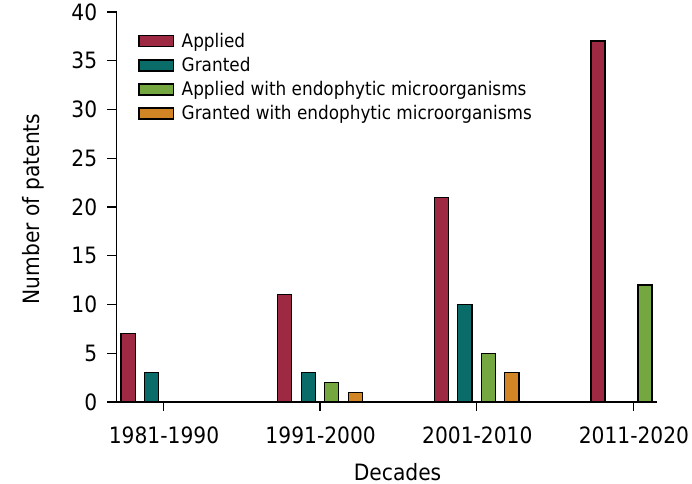
Figure 1. Total number of applied and granted patents in Brazil with rhizospheric and endophytic microorganisms for use in agriculture per decade.